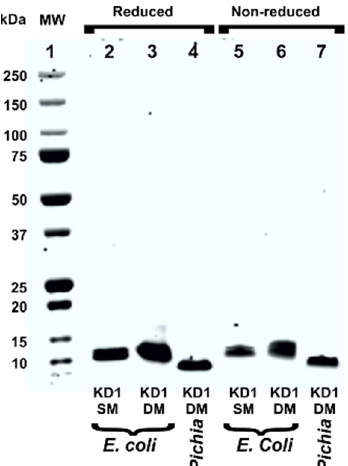
Figure 2. SDS-PAGE analysis of TFPI-2 KD1 single and double mutants. Lane 1, molecular weight (MW) markers; lane 2, reduced E.coli KD1-L17R-K COOH ; lane 3, reduced E.coli KD1-Y11T/L17R-K COOH ; lane 4, reduced P. pastoris KD1-Y11T/L17R-K COOH ; lane 5, nonreduced E. coli KD1-L17R-K COOH ; lane 6, nonreduced E. coli KD1-Y11T/L17R-K COOH ; lane 7, nonreduced P. pastoris KD1-Y11T/L17R-K COOH . Five µg of protein was loaded in each lane. KD1SM, KD1-L17R-K COOH ; and KD1DM, KD1-Y11T/L17R-K COOH .